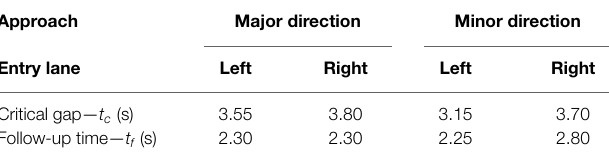
TABLE 3 | Dutch values for gap acceptance parameters on turbo